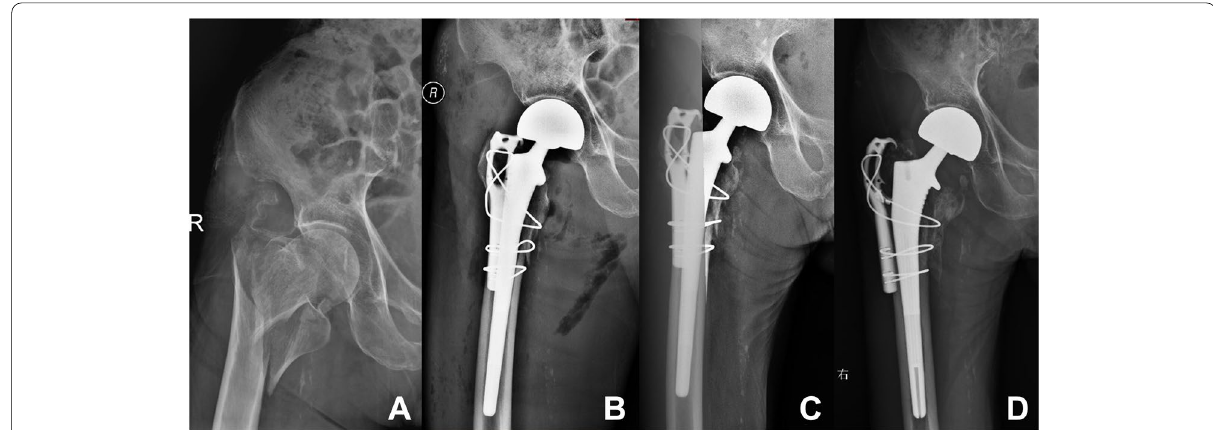
Fig. 3 Radiographic illustrations of an 87-year-old (at the time of the surgery) male patient. A Pre-operative X-ray indicated unstable ITC fracture and osteoporosis; B Postoperative X-ray of the patient two days after the operation; C Follow-up X-ray of the patient three months after the operation; D Follow-up X-ray of the patient 18 months after the